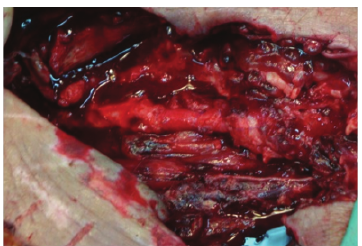
Figure 2: Internal iliac interposition arterial graft with end-to-end anastomosis.